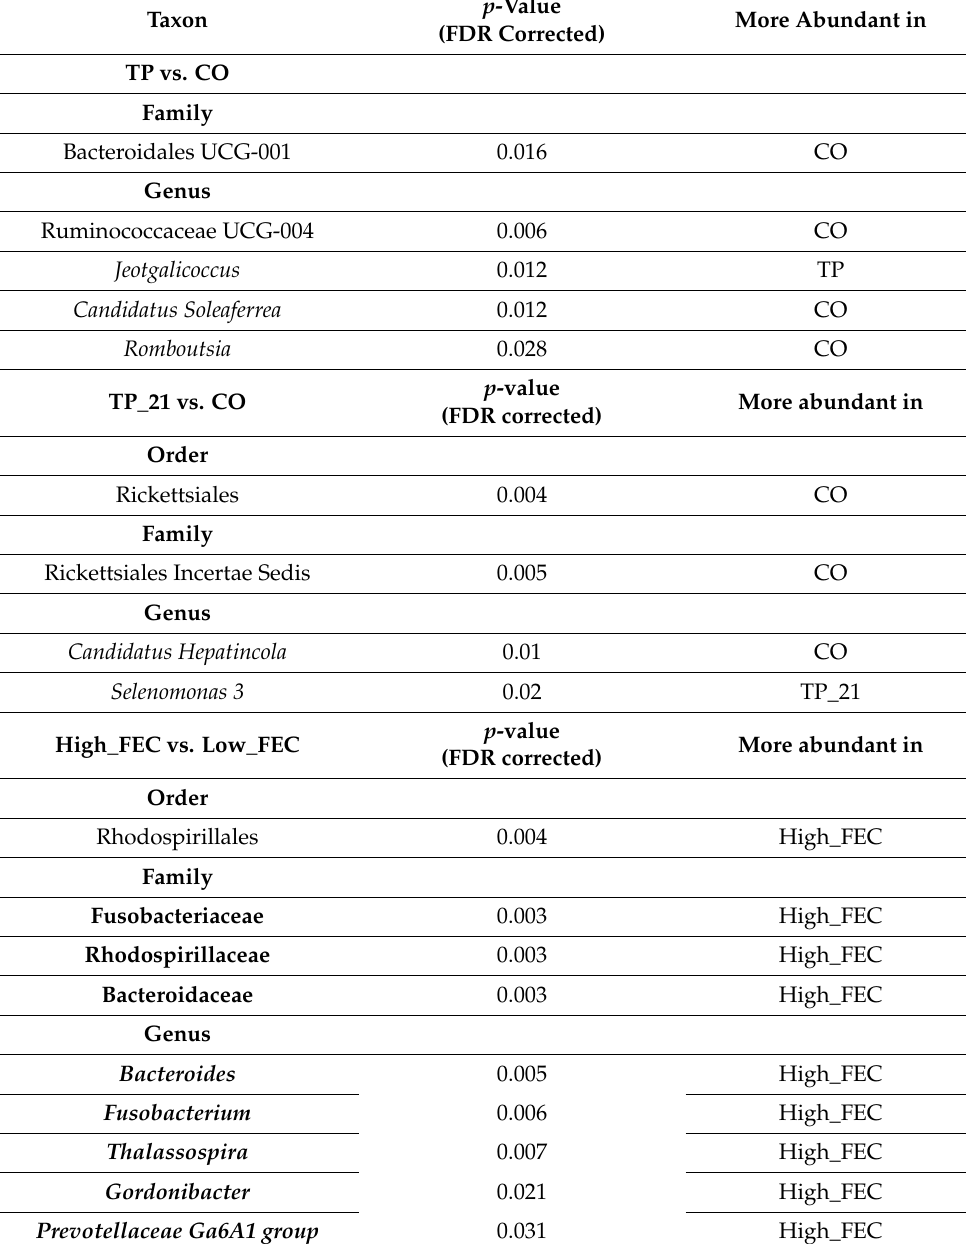
Table 1. Taxa that were significantly different in abundance between tapeworm groups and controls and those with high and low FEC, irrespective of tapeworm infection.